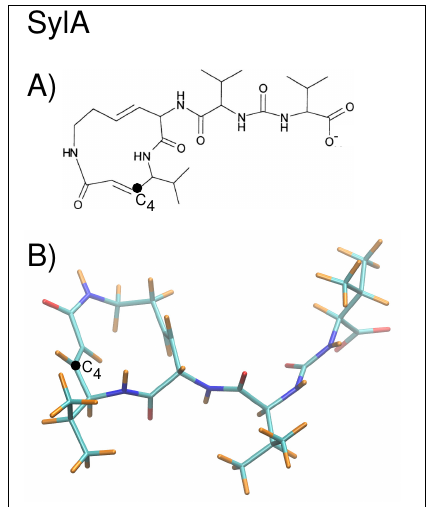
Figure 3. ( A ) A stick diagram of the SylA inhibitor is shown with C 4 labeled; ( B ) the non-planar structure of SylA is shown with carbons in cyan, oxygens in red, nitrogens in blue, and hydrogens in orange; C 4 is